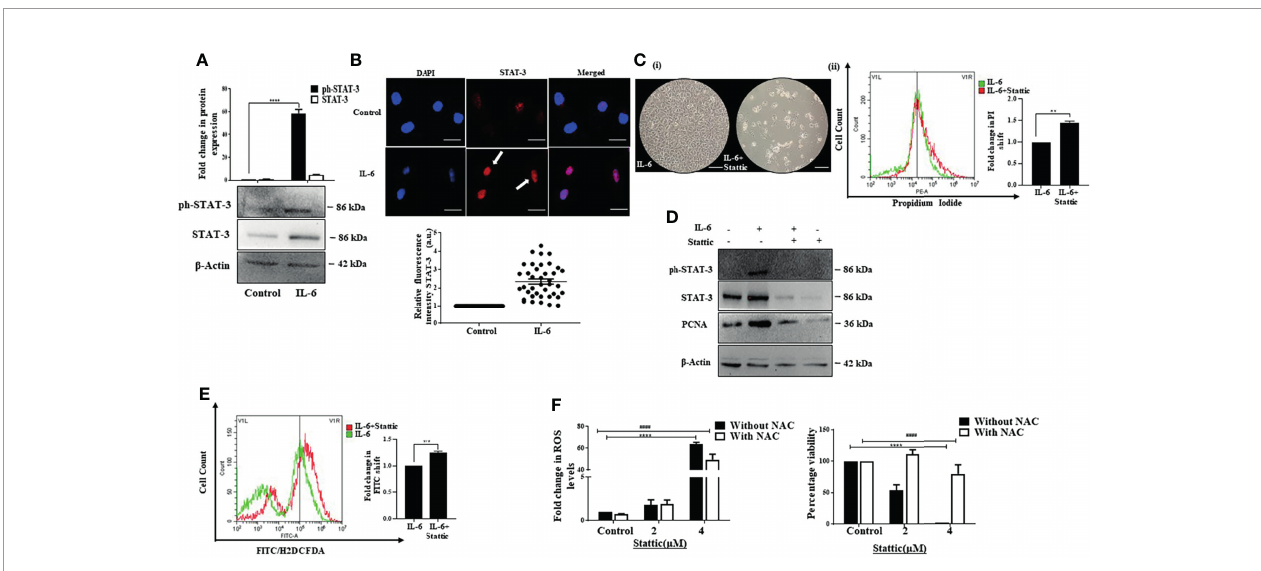
FIGURE 3 | Stattic generates ROS and abrogates IL-6-induced proliferative effects. (A) Immunoblot showing expression of STAT-3 after 72 h of IL-6 exposure. (B) Immuno fl uorescence image and relative fl uorescence intensity of STAT-3 in untreated and IL-6-treated cells (scale bar: 10 m m). The white arrow denotes STAT-3 protein. (C) (i) Phase-contrast image showing cells after IL-6, or IL-6 plus Stattic treatment post 24 h (scale bar: 100 m m); (ii) graph denoting PI fl uorescence after IL- 6, or IL-6 plus Stattic (2 m M) treatment post 24 h (D) Immunoblot showing expression of STAT-3 and PCNA in IL-6 and IL-6 plus Stattic (2 m M) treated cells after 24 h of exposure. (E) Graph representing a shift in green fl uorescence indicating ROS levels post-Stattic (2 m M) treatment in IL-6 exposed cells after 24 h. (F) Analysis of intracellular ROS levels and corresponding cell viability after 24 h of Stattic exposure. **, *** and **** refers to p value signi fi cance of ≤ 0.01, ≤ 0.001 & ≤ 0.0001 respectively. #### represents a comparison between two groups with a signi fi cance of ≤